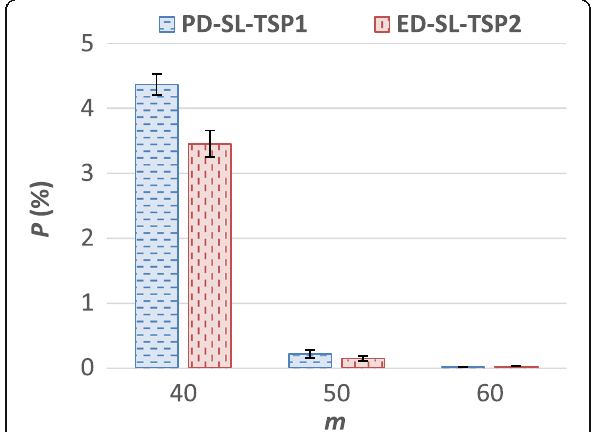
Fig. 12 Effect of m on P when using the CyberShake